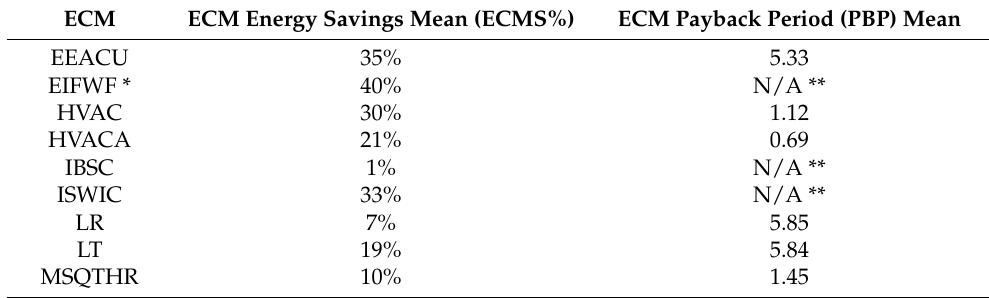
Table 6. ECMS savings % of the total energy consumption savings, ECMS% Mean.